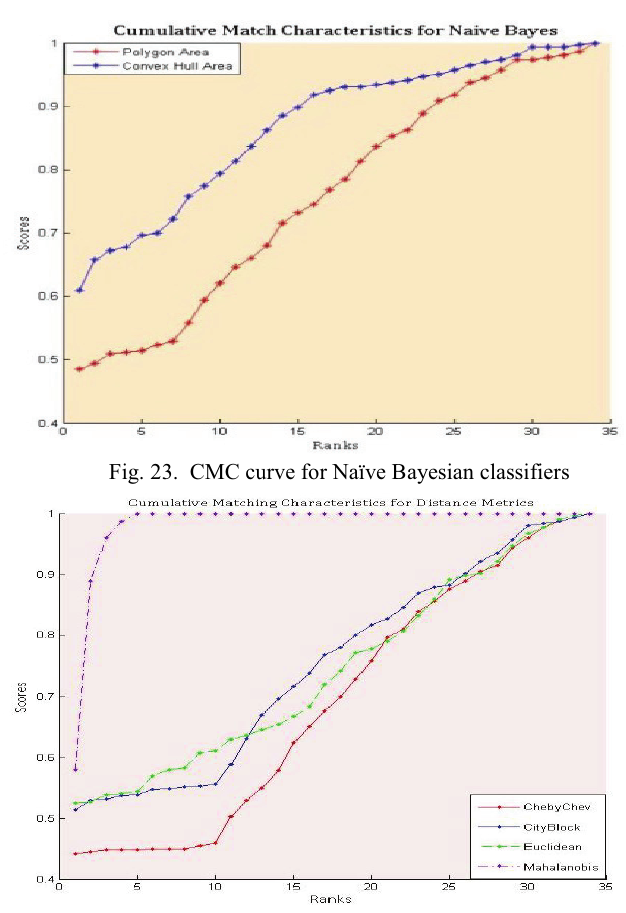
Fig. 24. CMC curve for Distance based